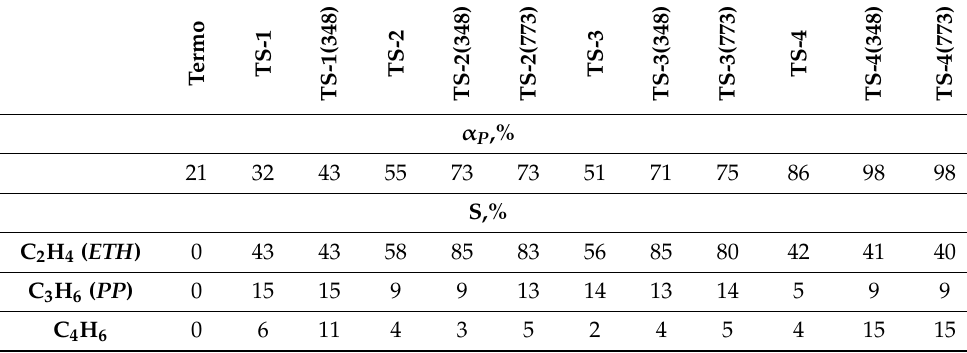
Table 16. Optimal propane cracking reaction performance (T = 973 K) (data from